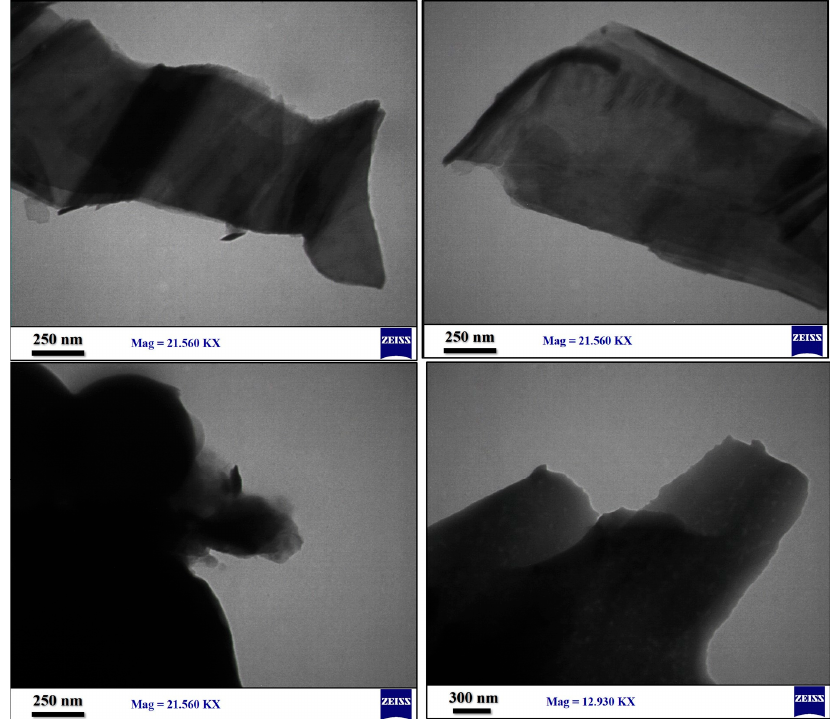
Figure 6. TEM micrographs of PBZ.